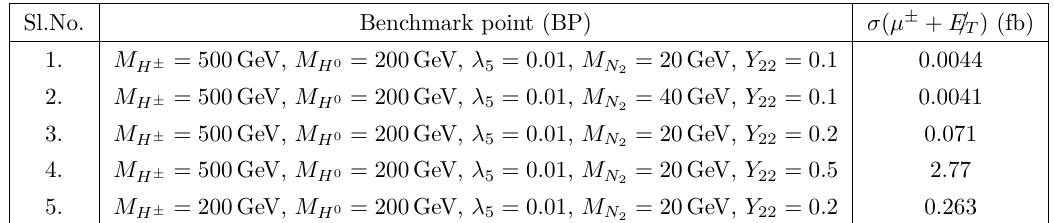
Table 8 . Production cross-section of the monomuon + /E T final state in Toy Model I.